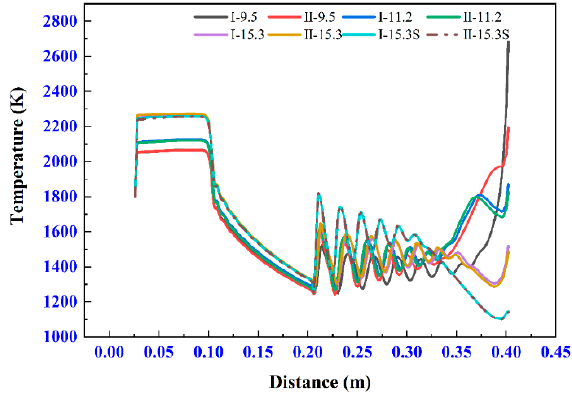
Figure 11. Temperature at the axis of the